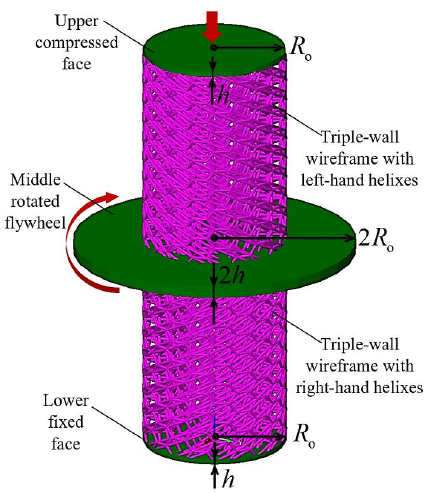
Figure 1. Design of the proposed metamaterial-based joint.